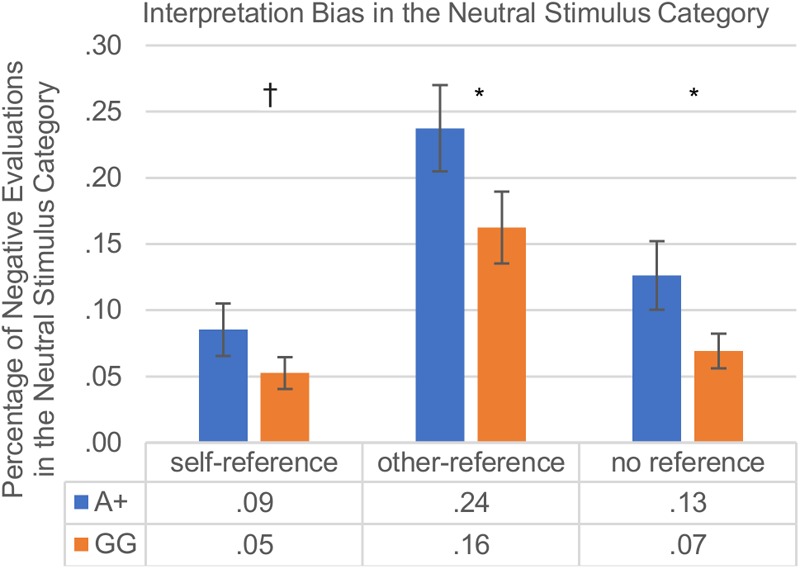
Interpretation bias in neutral words with self-reference vs. other-reference vs. no reference in percent; group comparison: rs53576-A+ vs. rs53576-GG carriers. Vertical bars denote ±SE (†p ≤ 0.1; ∗p ≤ 0.05). As described in detail under the section “Procedure” a high score (>0.5) indicates a negativity bias in the reaction towards neutral words, whereas a low score (<0.5) indicates a positivity bias.